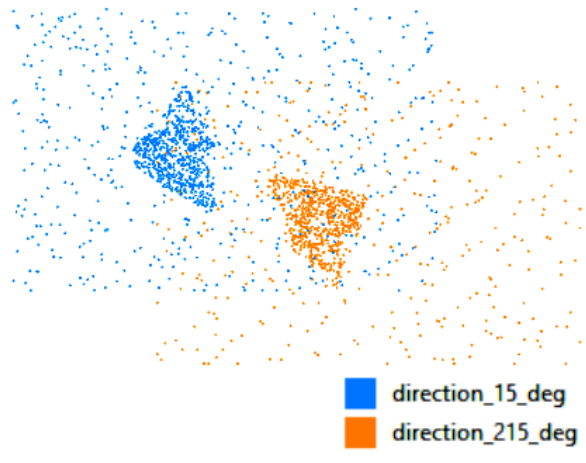
Figure 6. Velocity fields for wind directions 15°, 215°are not registered in the same spatial reference.